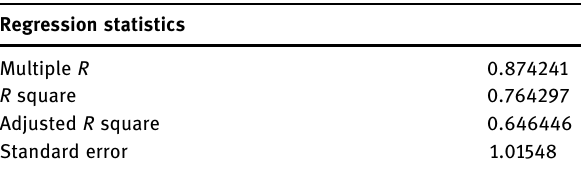
Table 3: Regression analysis of tensile strength and